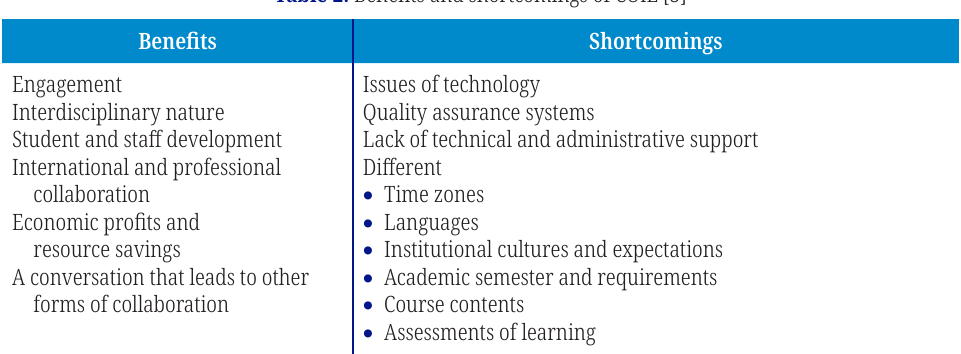
Table 2. Benefits and shortcomings of COIL